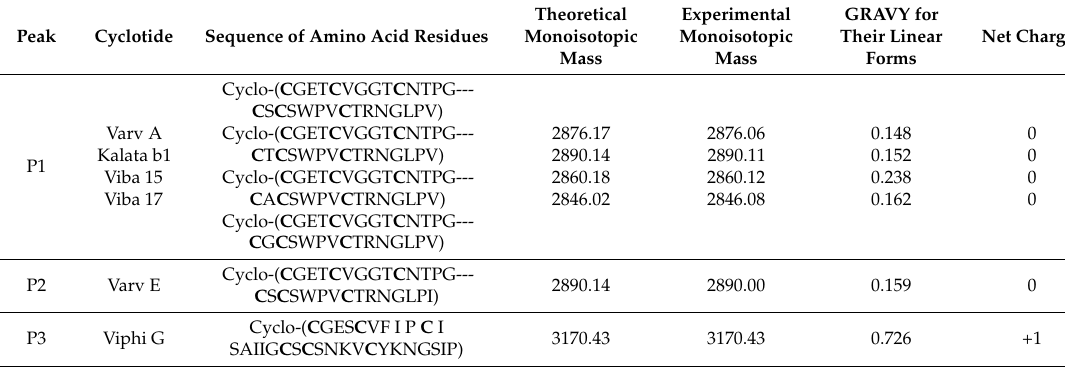
Table 1. Cyclotides isolated and identified from V. philippica.